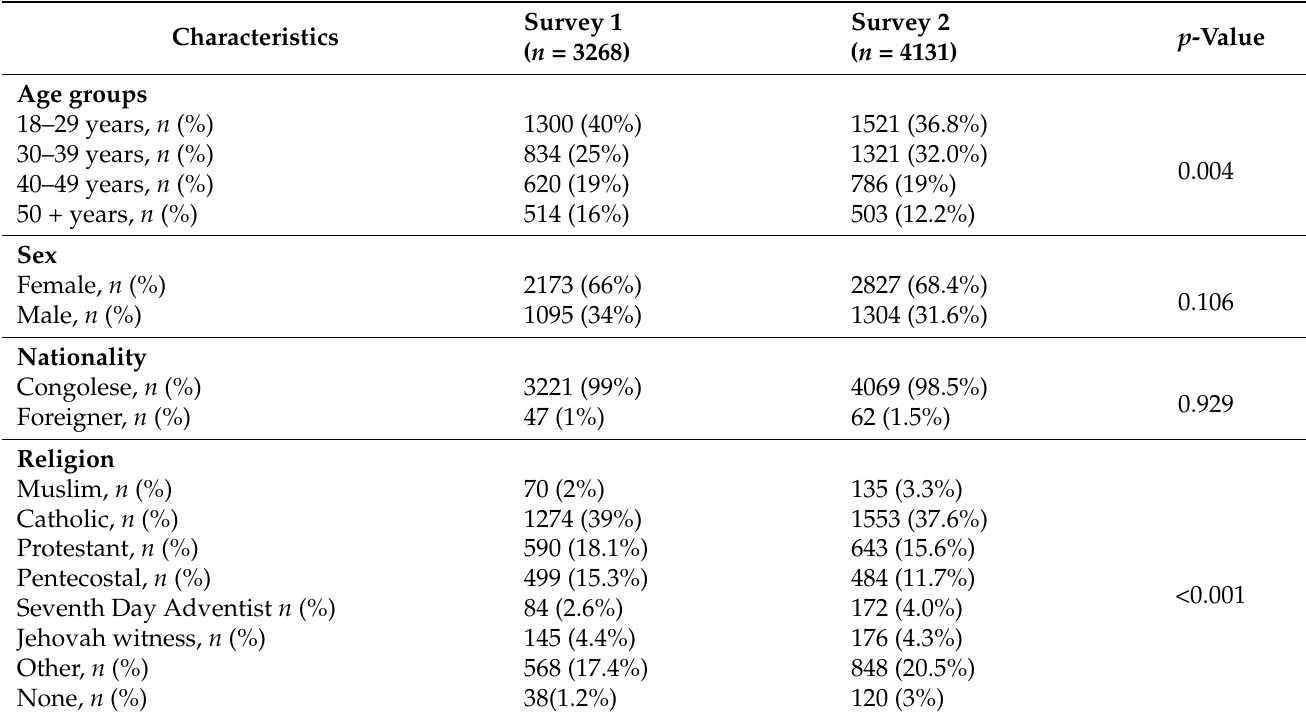
Table 2. Participants’ characteristics in the first and second